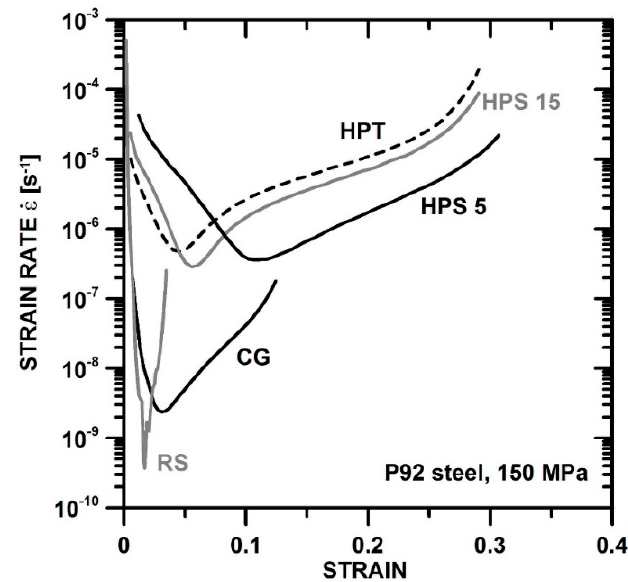
Figure 6. Evolution of strain rate with strain in tensile creep at constant load with σ 0 = 150 MPa for di ff erent SPD strains ε SPD .